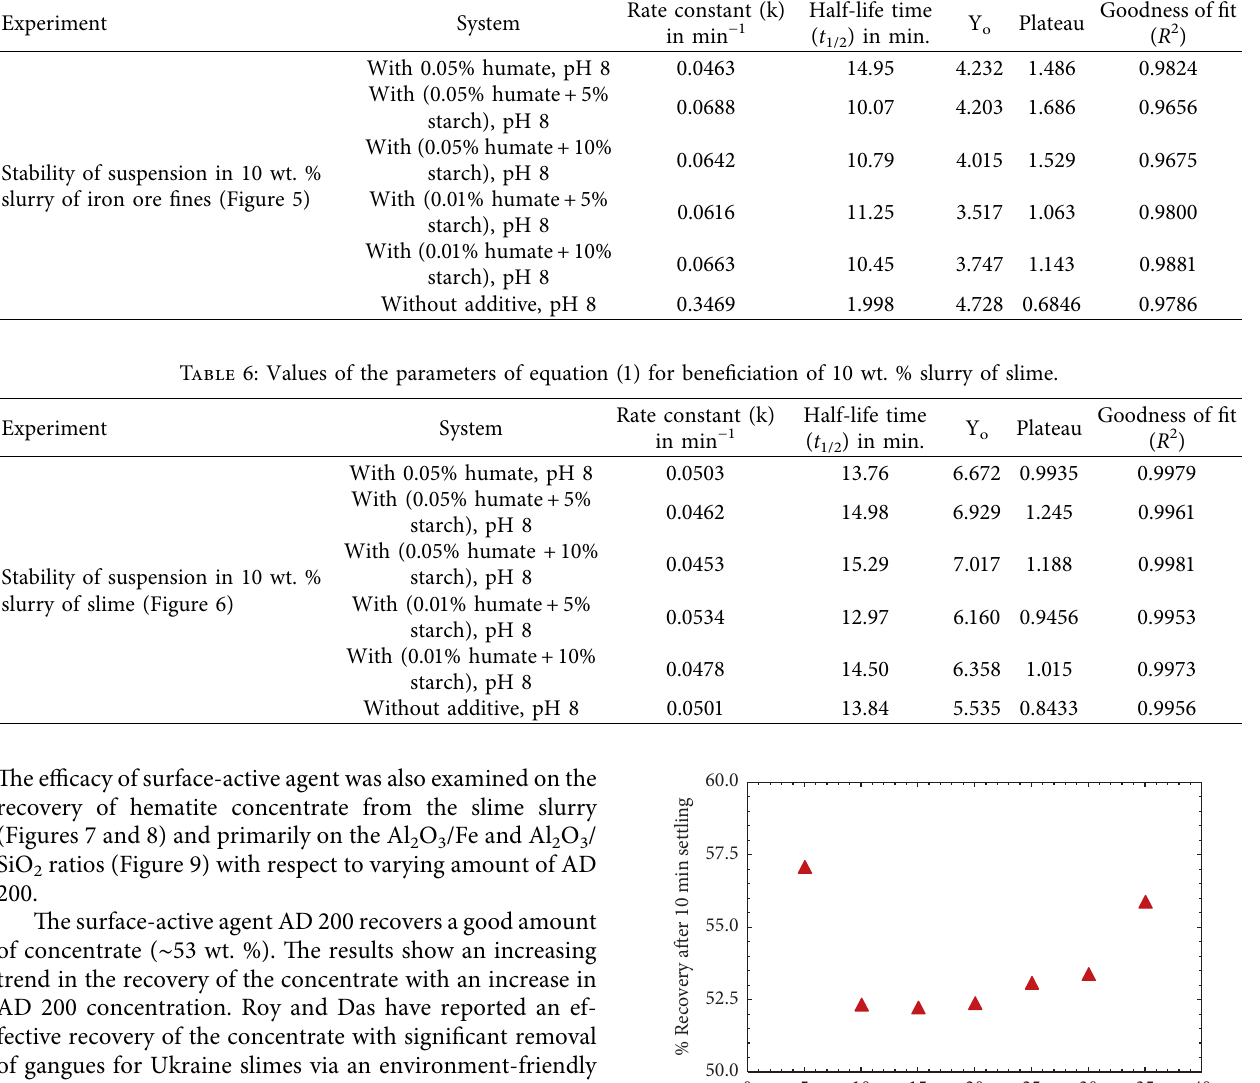
Table 5: Values of the parameters of equation (1) for beneficiation of 10 wt. % slurry of fines. Experiment